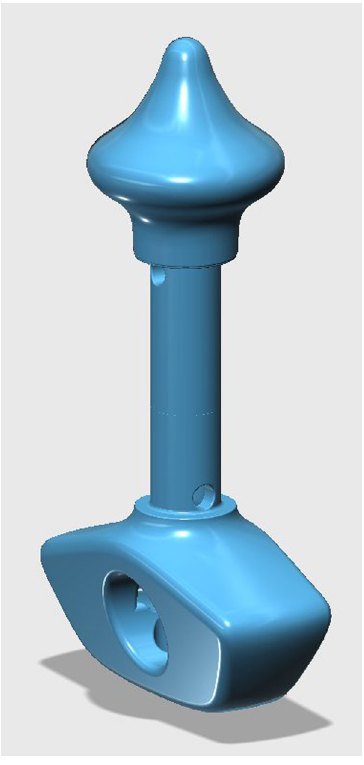
Figure 13: 3D model of anal probe.